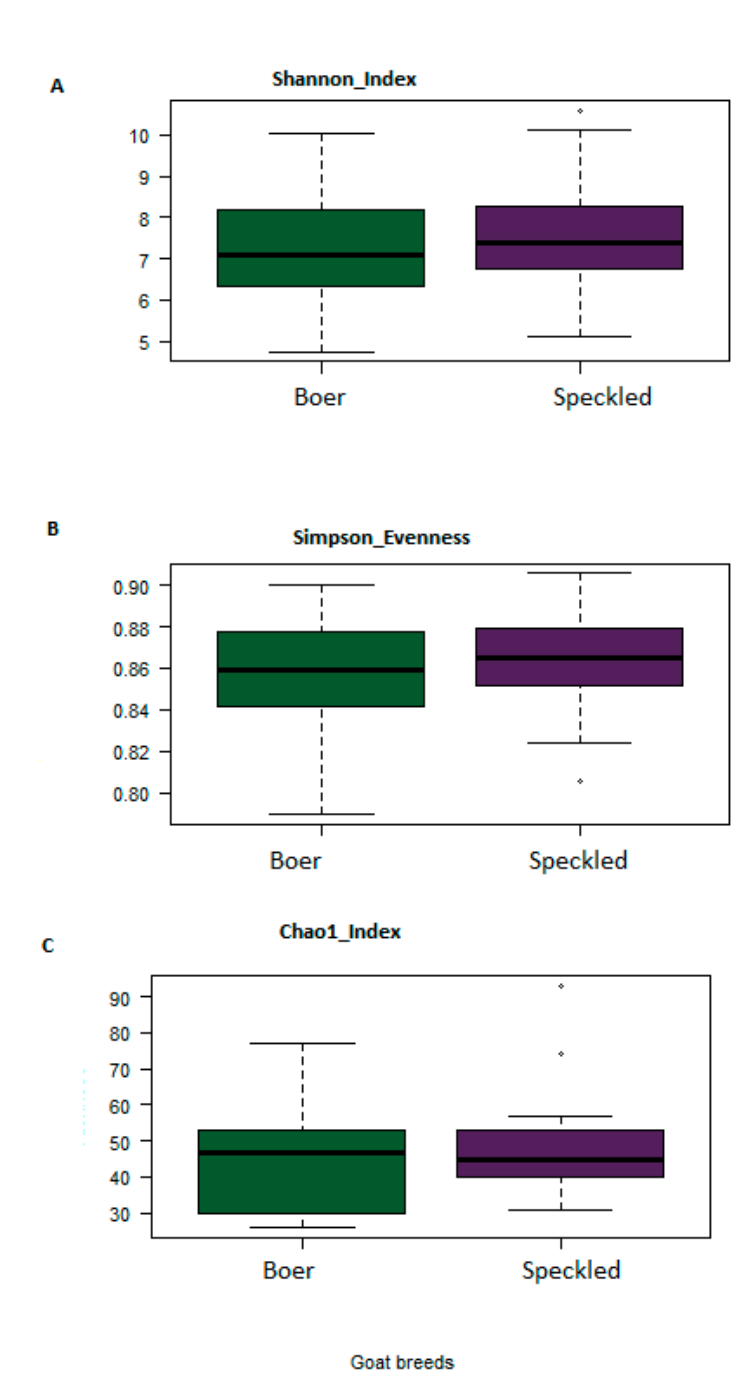
Figure 5. Alpha diversities within Boer and Speckled goats on day 30 of the trial. Blue (Boer), and purple (Speckled). Three indices were measured: Shannon index ( A ) Simpson evenness ( B ) and Chao1 ( C ). The top and bottom boundaries indicate the 75th and 25th quartile values, respectively. The horizontal lines within each box represent median values.